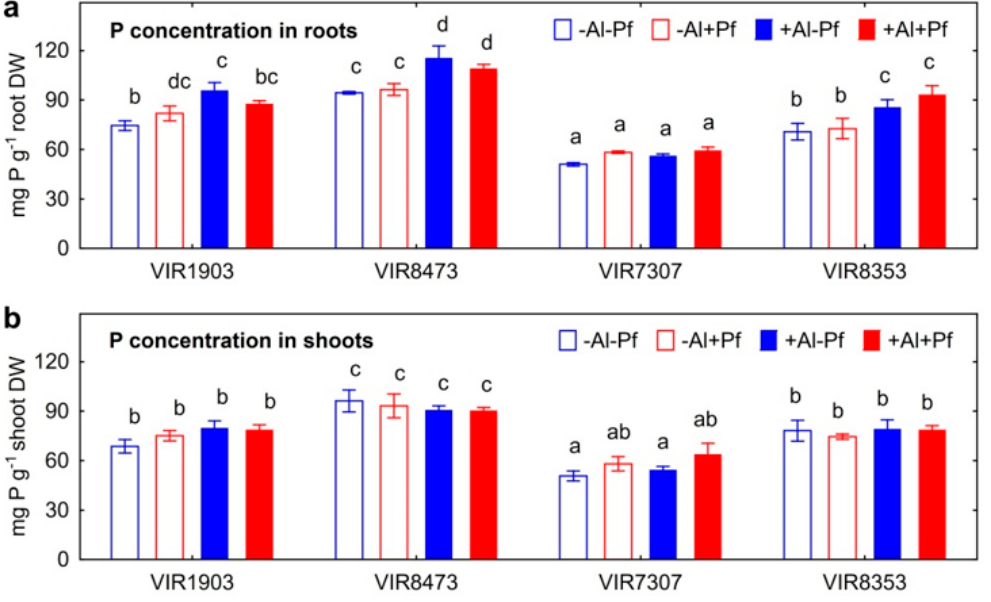
Figure 9. Effect of Pseudomonas fluorescens SPB2137 on concentration of P in roots ( a ) and shoots ( b ) where pea genotypes VIR1903, VIR8473, VIR7307 and VIR8353 untreated and treated with 80 µm AlCl 3 . Treatments: − Al − Pf—Al-untreated and uninoculated control plants, − Al+Pf—Al-untreated and inoculated plants, +Al − Pf—Al-treated and uninoculated plants, +Al+Pf—Al-treated and inoculated plants. Vertical bars show standard errors. Different lowercase letters show significant differences between treatments (least significant difference test, p < 0.05, n = 3). DW stands for dry weight.